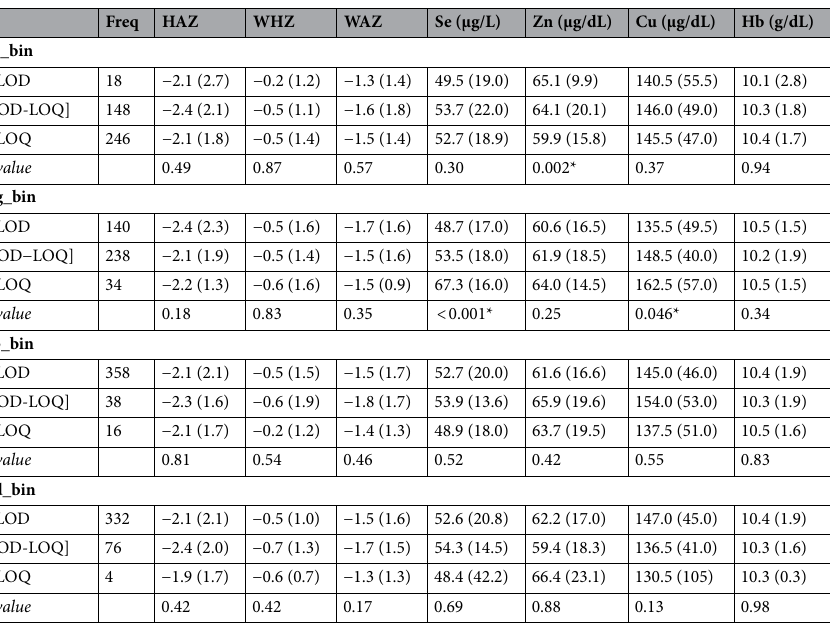
Table 5. Differences in the Median (interquantile range) level of some nutrition indicators across the HM levels using the Kruskal wallis test. * means significant pvalue. HAZ = height-for-age Zscore; WHZ = weight- for-height Zscore; WAZ = weight-for-age Zscore; Se = selenium; Zn = Zinc; Cu = copper; Hb =